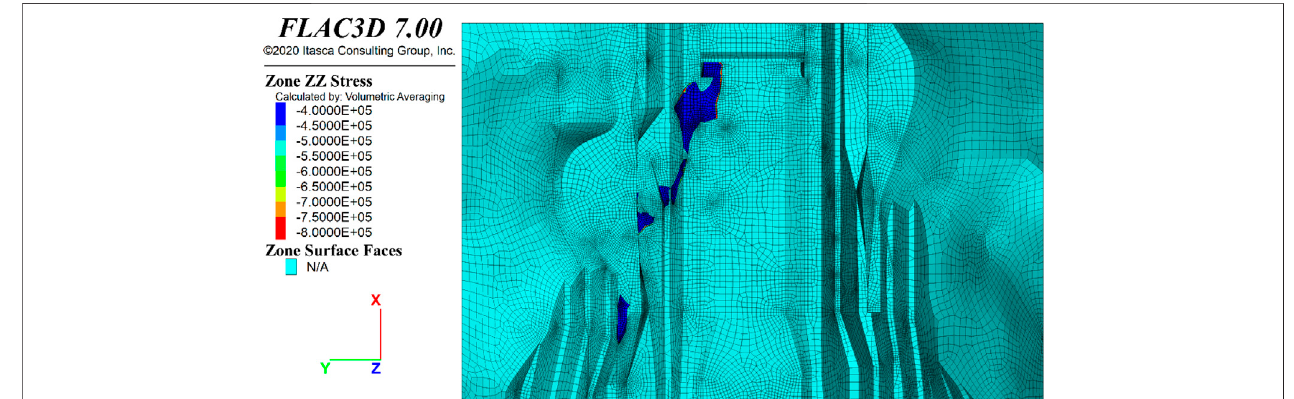
FIGURE 9 | The vertical normal stress Szz higher than 400 kPa of sericitized slate at the bottom of stilling basin.